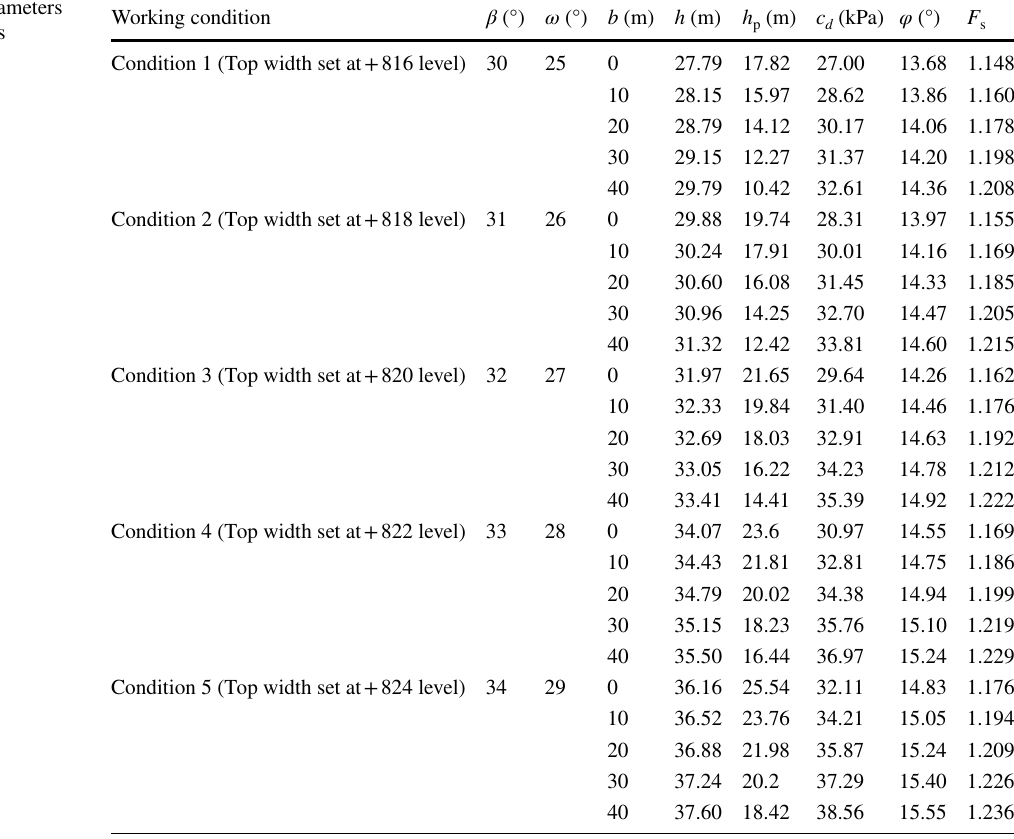
Table 4 Calculation parameters and results under various working conditions